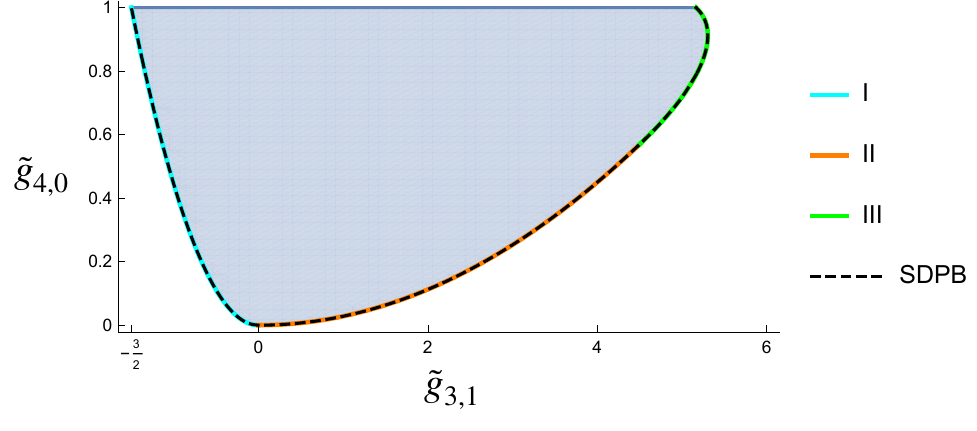
Figure 2 . ( ˜ g 3 , 1 , ˜ g 4 , 0 ) space with the k = 4 null constraint, geometry vs